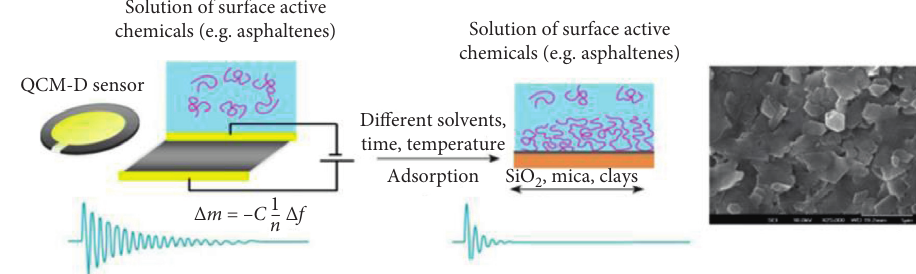
Figure 1: The working principle of quartz crystal microbalance. Table 1: Four component analysis results of crude